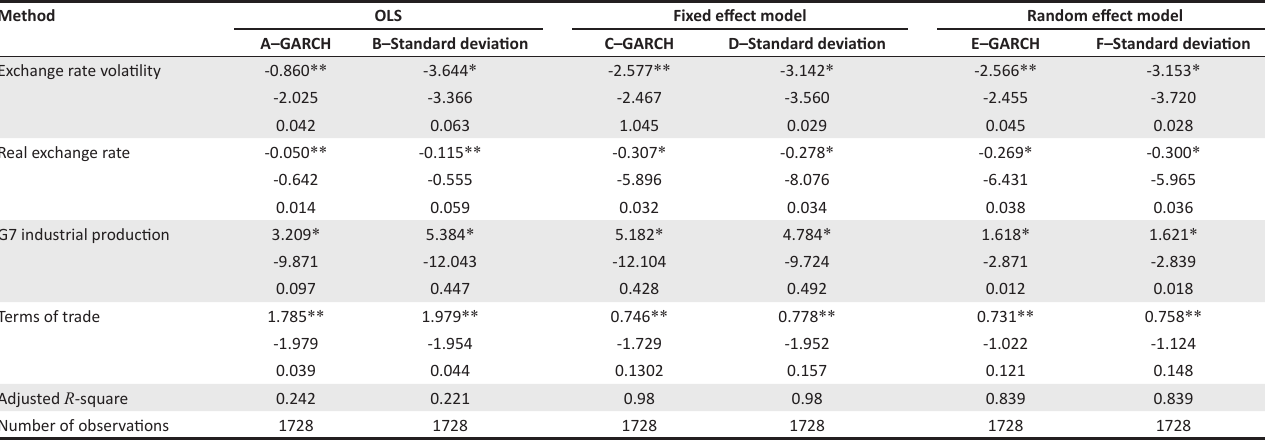
TABLE 11: Dependent variable: Exports. Method OLS Fixed effect model